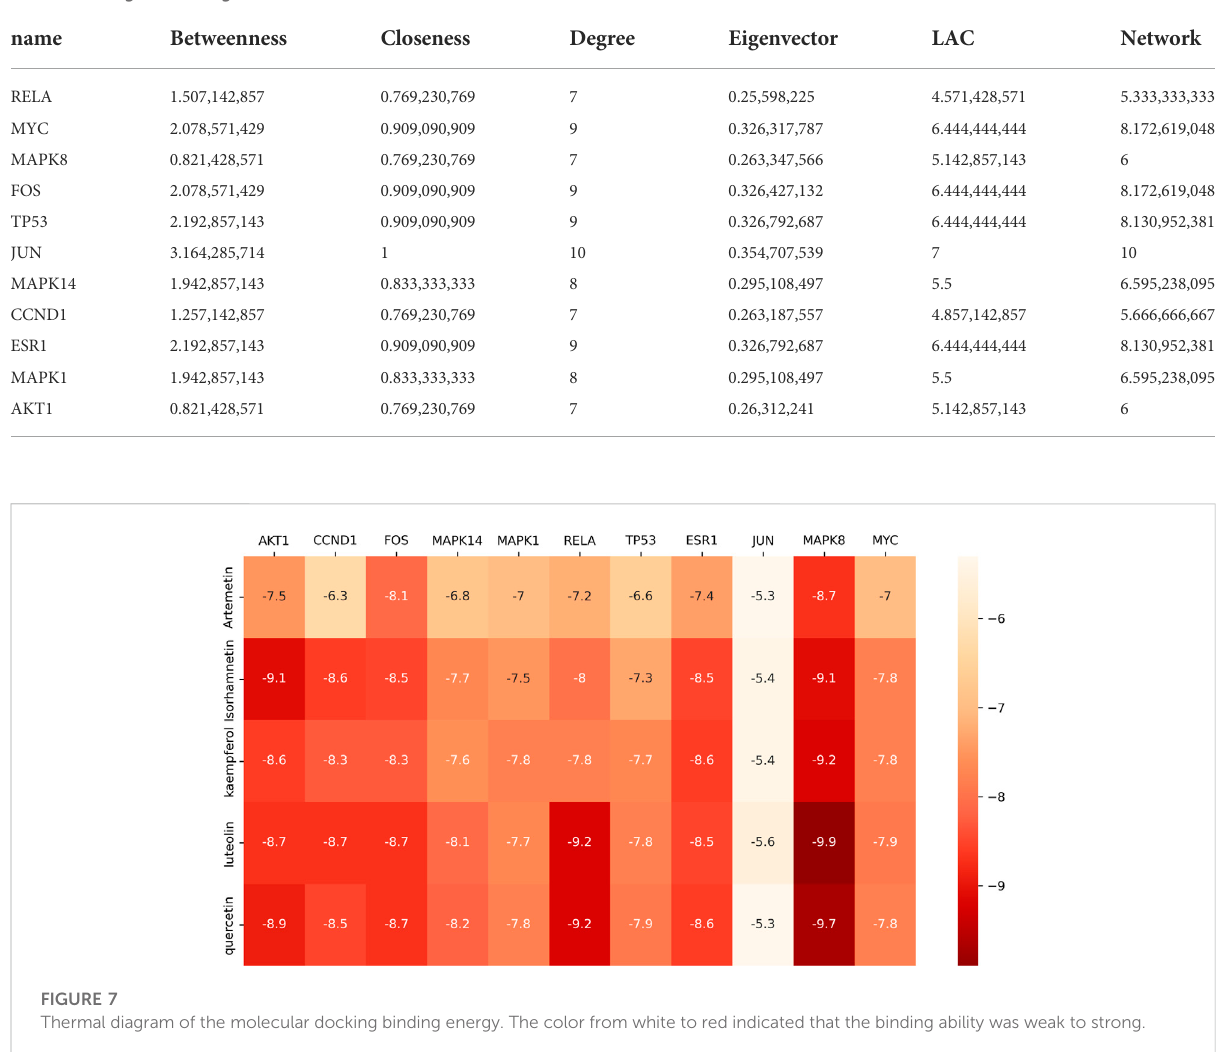
TABLE 2 Hub genes of degree value in the PPI network.